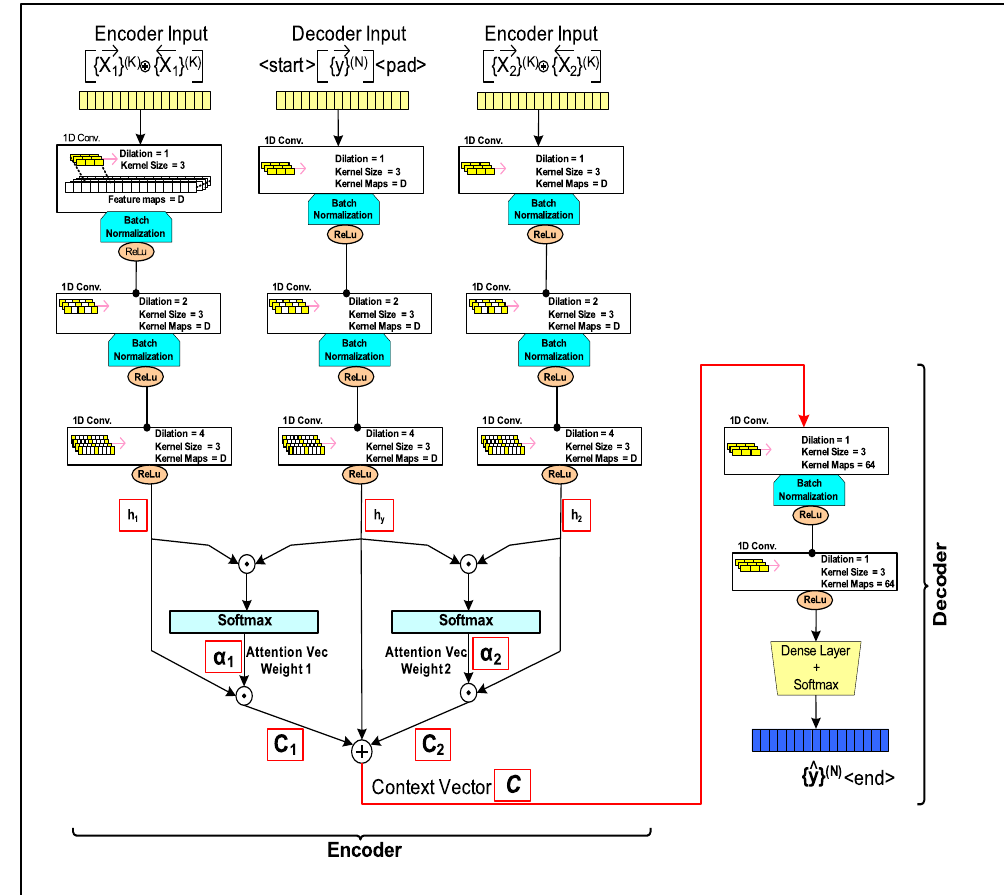
Figure 11. Trident Model: Contains stacked 1D convolutional neural network (CNN) layers to build a parallel architecture that uses dot product attention layers for its encoder-decoder network. Intermediate deeper CNN layer have larger (1, 2, 4) dilated kernel filters to increase the receptive filed of the convolution maps to capture longer